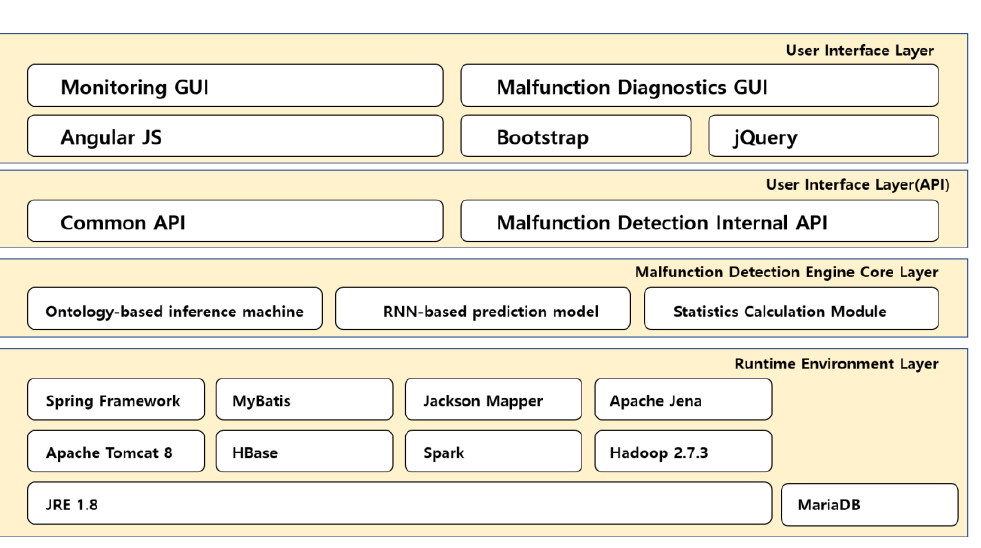
Figure 4. Software architecture of the malfunction detection system for ventilation devices in smart poultry farms.